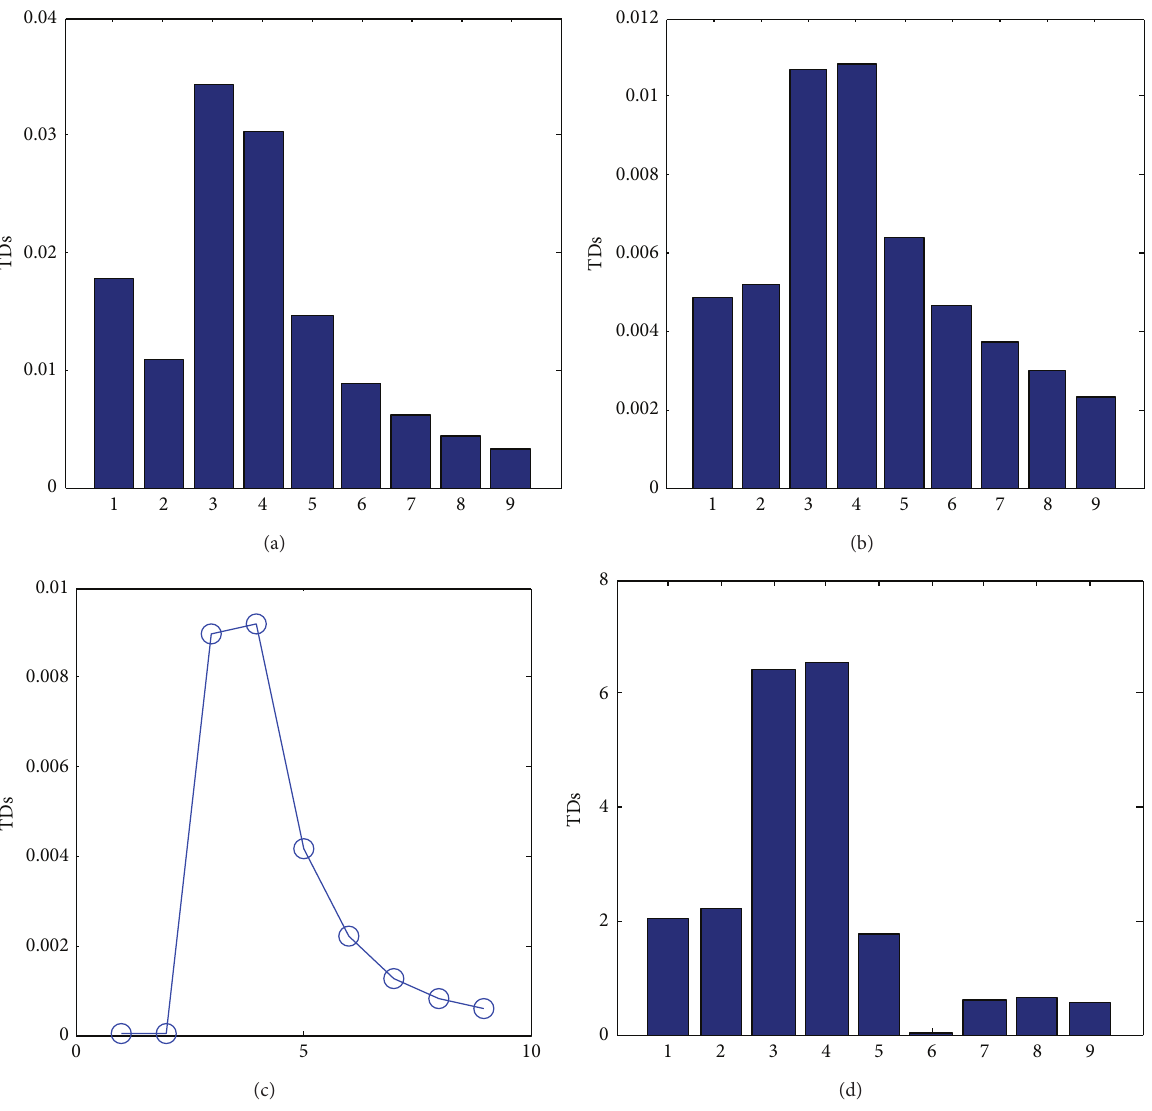
Figure 12: Detection indicators of the cantilever beam when 𝛾 = 0 . 2 with frequency band of 0–100 Hz: (a) this paper, (b) Schulz et al. [4], (c) magnitude value of Zhang et al. [6], and (d) Johnson and Adams